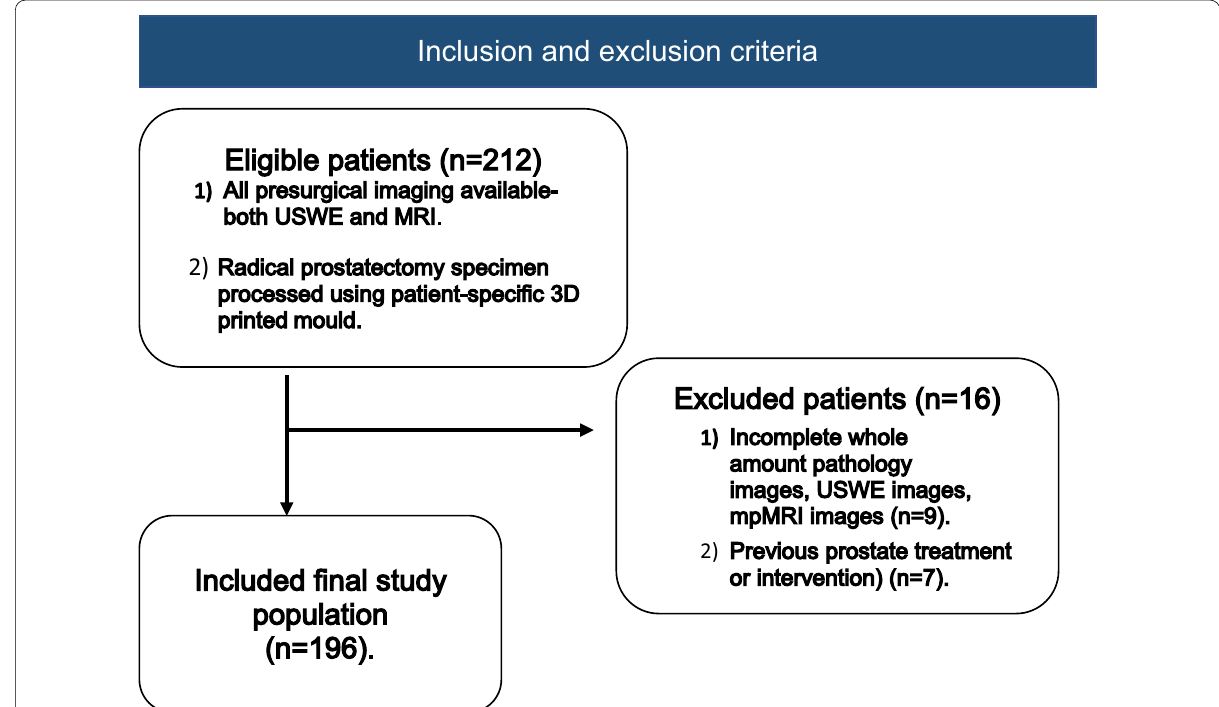
Fig. 1 Flowchart shows inclusion and exclusion criteria and the patients selection process